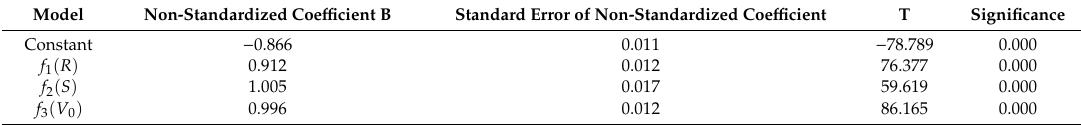
Table 13. Coe ffi